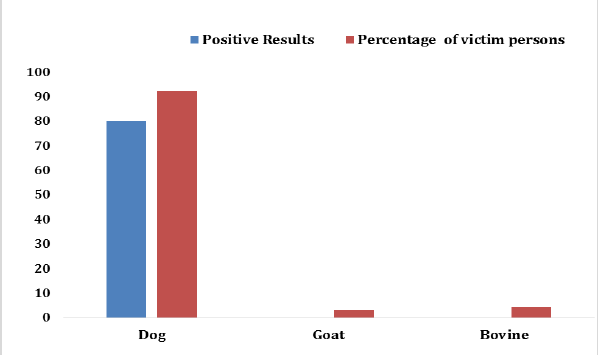
Figure 2. Rabies exposure Laboratory findings and human victims by animal bite during investigation time and area